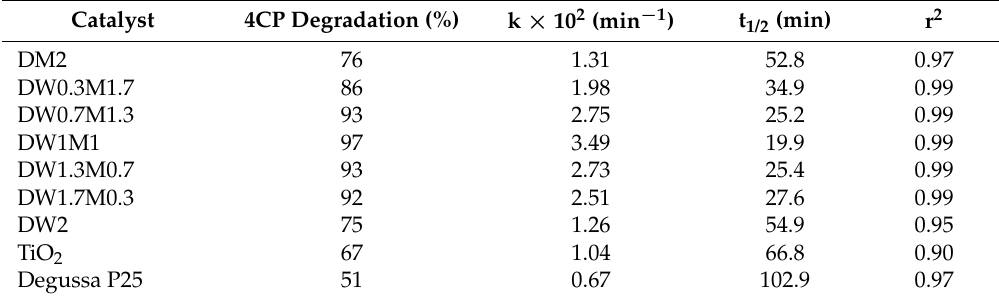
Table 4. Removal percentages, apparent kinetic constant, half-time and regression coefficient for 4CP degradation.